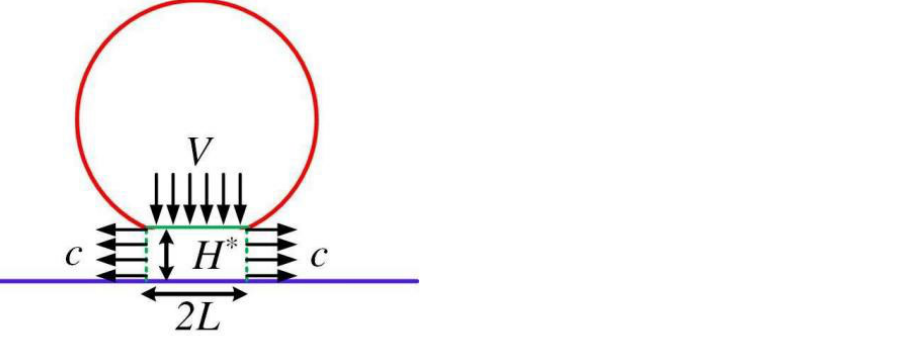
Figure 4. Estimate of height H ∗ . The sound speed in the gas is denoted by c . The solid green line denotes the drop bottom. The solid and dashed green lines constitute a control volume.